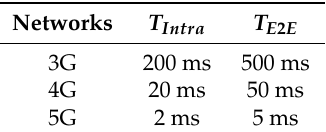
Table 3. Network delays for 3G, 4G, and 5G networks.